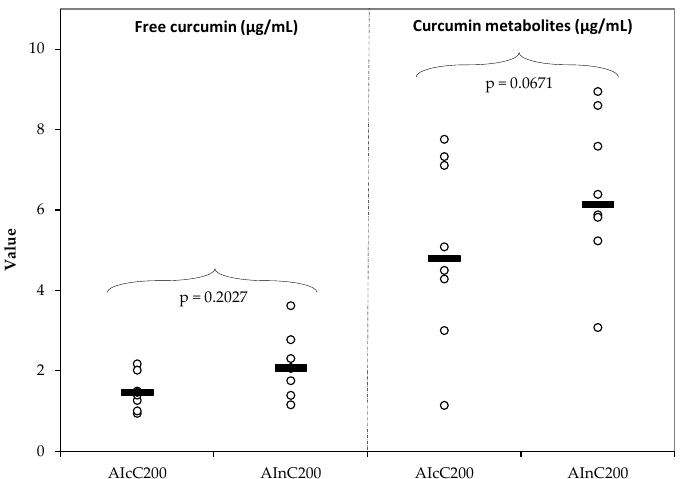
Figure 8. Variation of cC and nC: free curcumin before hydrolyzation and curcumin’s metabolites after hydrolyzation. AI—Acute inflammation; cC—conventional curcumin solution (200 mg/kg b.w.); nC—curcumin nanoparticles solution (200 mg/kg b.w.). The dots are the primary data and the line indicates the median value.